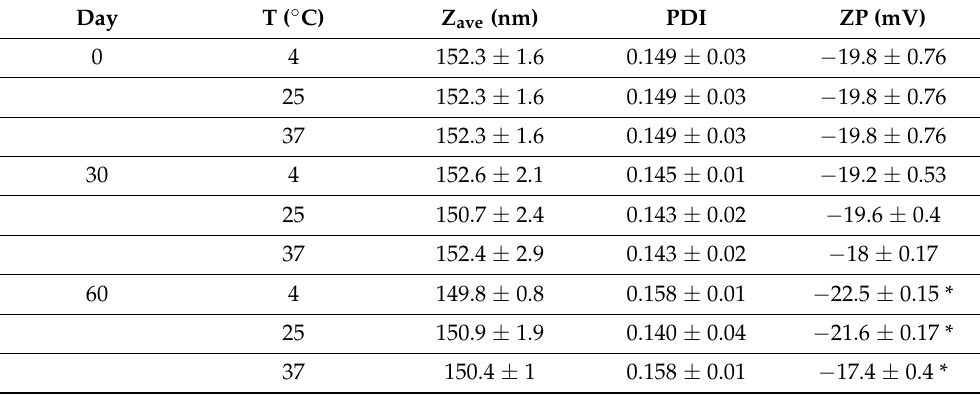
Table 6. Results of stability studies of DXI-loaded nanostructured lipid carriers (NLCs). Day T ( ◦ C) Z ave (nm) PDI ZP (mV)